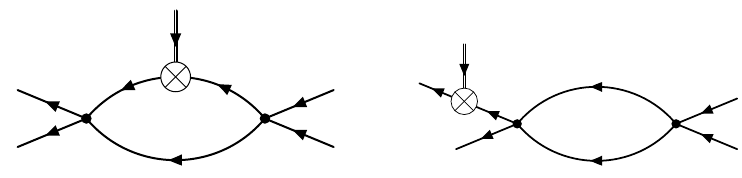
Figure 5 . One-loop diagrams for two-particle, length-one form